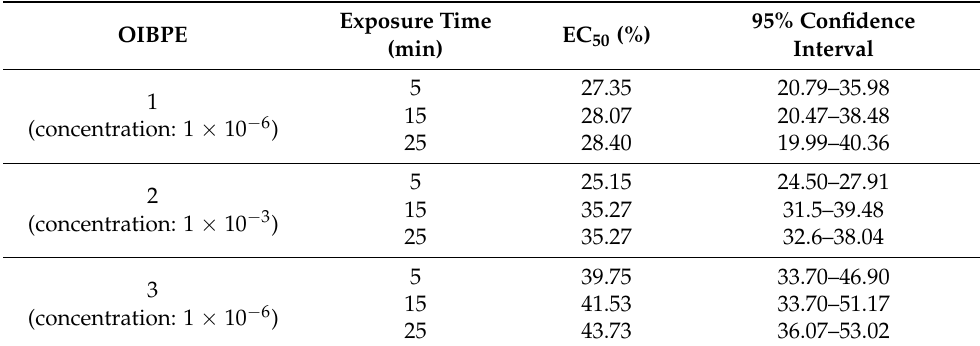
Table 6. EC 50 results obtained in the ecotoxicological evaluation of the extracts.